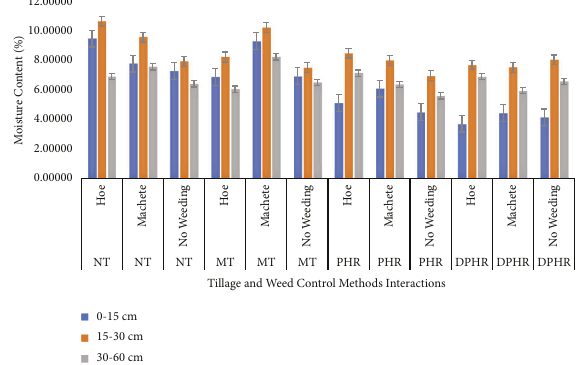
Figure 5: Tillage and weed control methods’ interaction effect on moisture content.